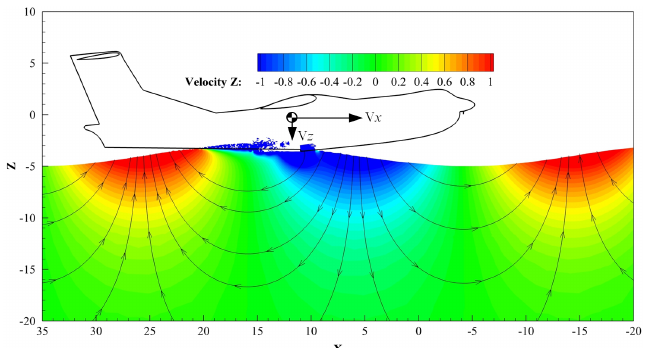
Figure 16. Vertical wave velocity of water field when aircraft landing on wave surface with H = 2 m at t = 0.16